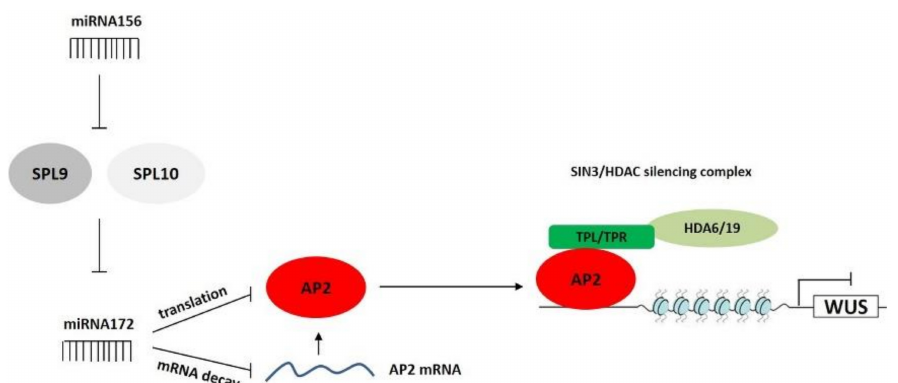
Figure 9. A putative model of the miR172-mediated regulatory interactions that control SE induction by repressing AP2 controls the WUS TF with a regulatory function in embryogenic induction. The AP2-controlled repression of WUS involves a Hac-related mechanism in which AP2 might recruit TOPLESS co-repressors (TPL, TPR1, TPR4) and histone deacetylases, HDA6 and HDA19, which are the central components of the SIN3/HDAC gene-silencing complex. Other miR172-related regulatory elements that might regulate SE induction include the miR156-SPL9/10 module, which has a negative impact on